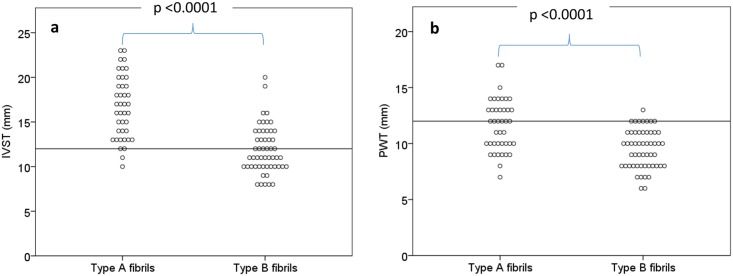

(a). Interventricular septal thickness in type A versus type B fibrils. Horizontal line represents the limit for increased septal thickness (12 mm). (b). Posterior wall thickness in type A versus type B fibrils. Horizontal line represents the limit for increased posterior wall thickness (12 mm).